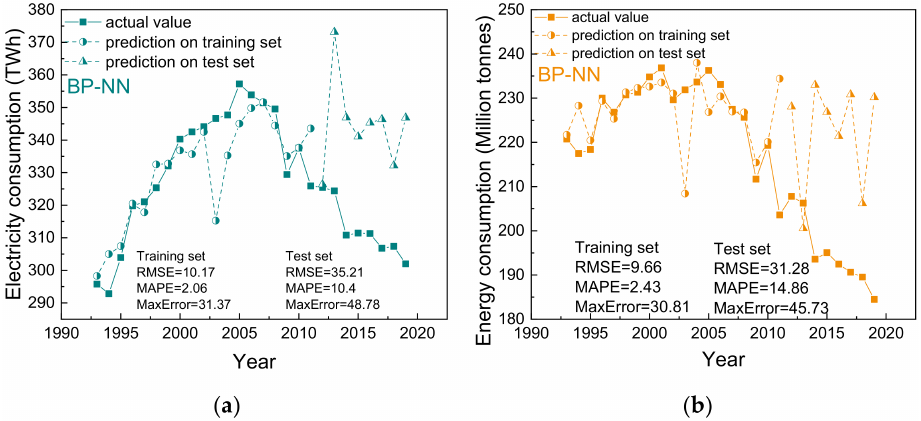
Figure 5. Results of BP-NN model. (( a ) electricity consumption; ( b ) energy